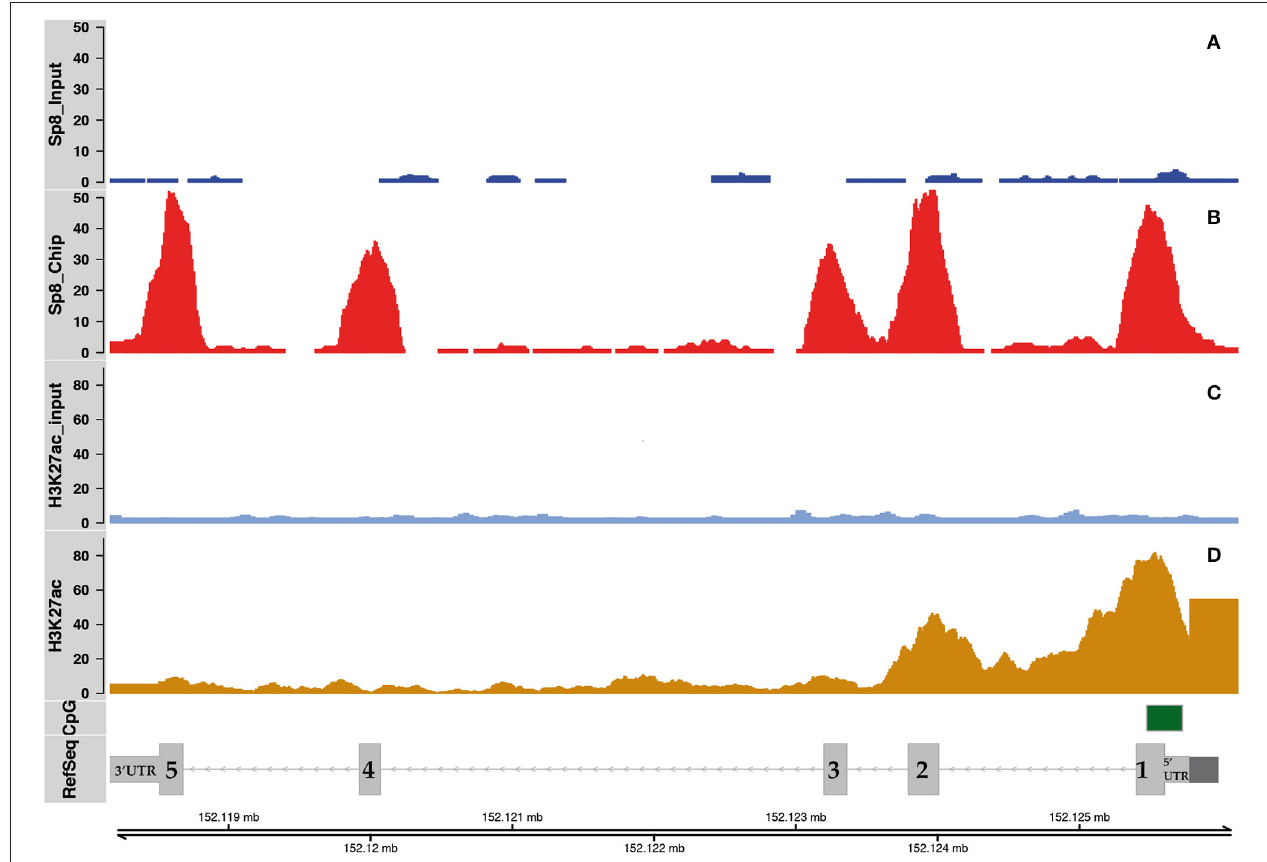
FIGURE 2 | SP8 binding regions on the Ccnd1 locus. Panels (A,B) show SP8 ChipSeq peaks in input and SP8 antibody (Ab) treated samples respectively. Panel (C) shows normalized H3K27ac ChipSeq peaks. Panel (D) shows Ccnd1 RefSeq gene model in light gray, the promoter ( Eto, 2000) in dark gray, and the CpG islands in green. Sp8 exons are numbered and the UTRs are